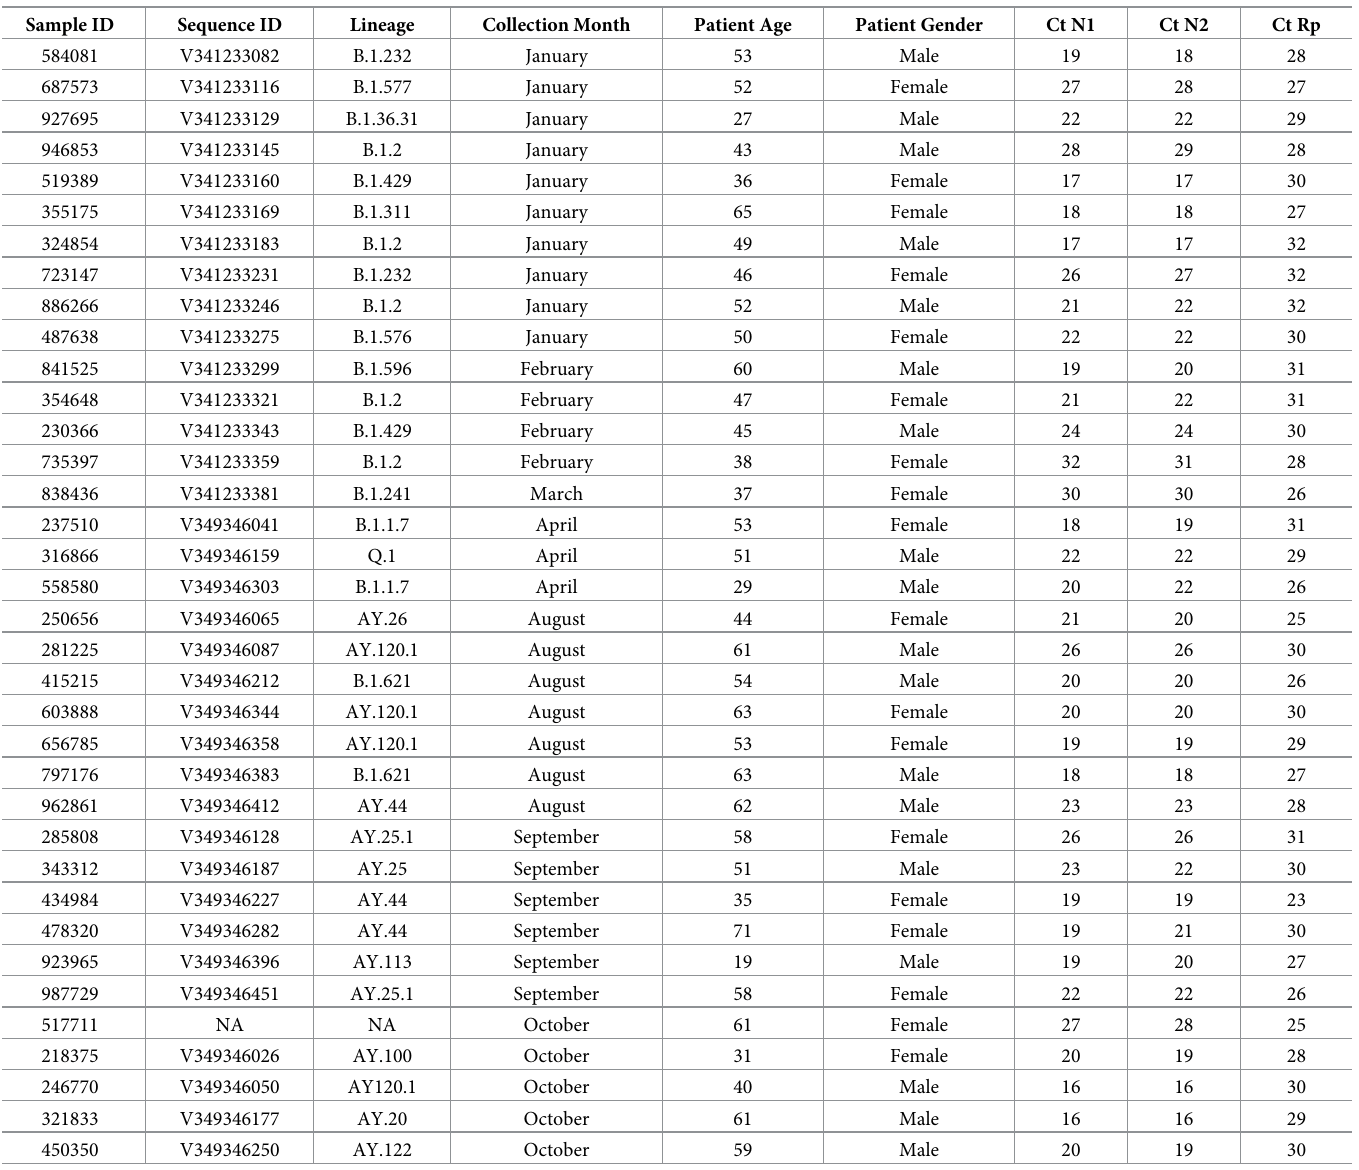
Table 1. Samples used in this